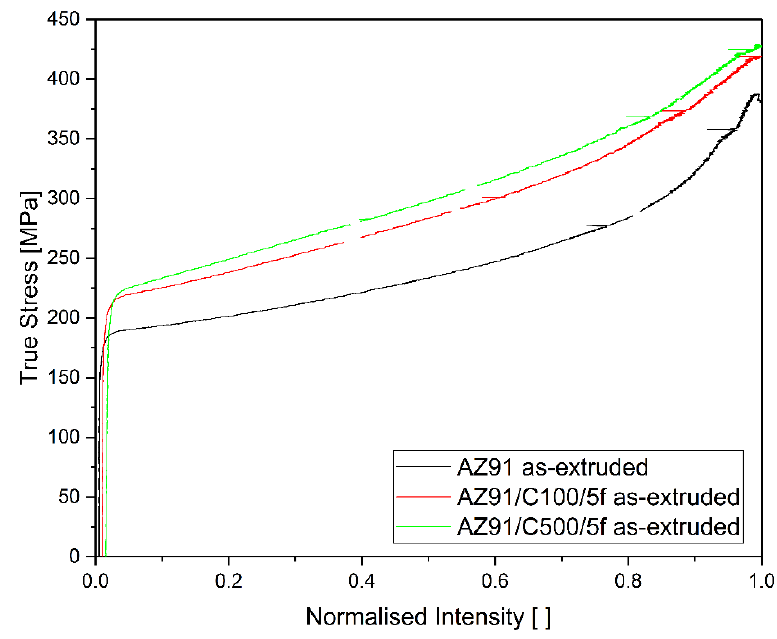
Figure 6. True stress against normalised intensity of the {00.2} planes for the as ‐ extruded samples.